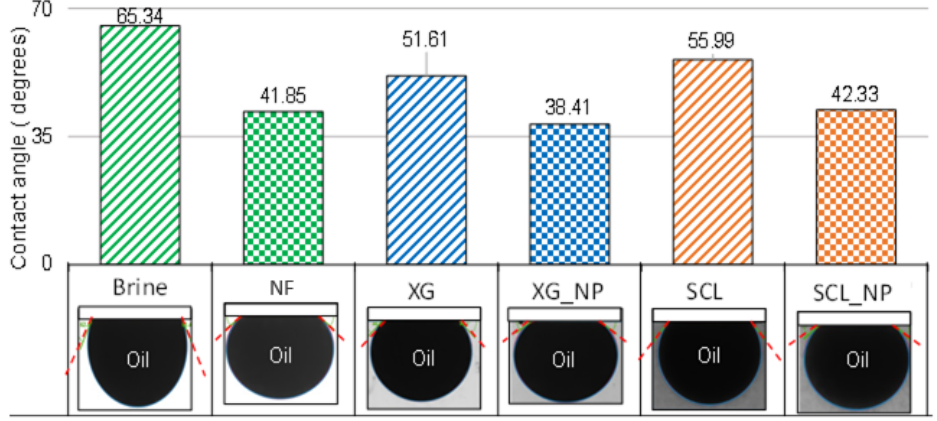
Figure 5. Results of the contact angle measurement for the fluids used in this study.